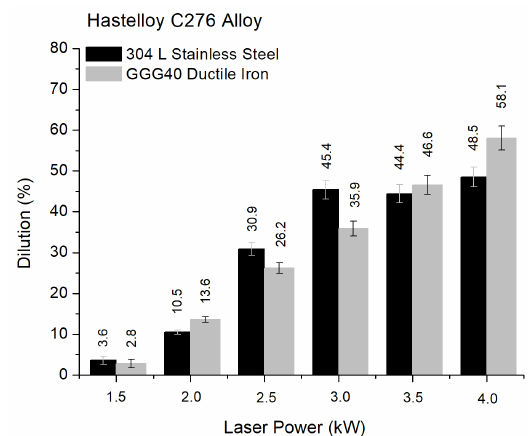
the iron content adopting Toyserkani method 8 , as seen in Figure 6 . Both dilution measurement techniques showed good correlation and close values and tendencies for the systems studied. It is important to highlight, especially for the lowest laser power condition, that the dilution values showed the